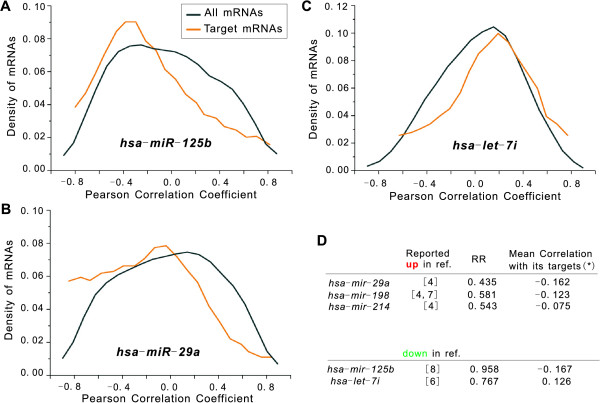
Relationship between the transcript levels of individual miRNAs and their targets in prostate cancer. Global density distribution of the Pearson correlation coefficients between the expression of mRNAs and the expression of miR-125b (A), miR-29a (B) and let-7i (C). The black-lined curves show the distribution of the correlation coefficients for all mRNAs and the orange-lined curves show the correlation coefficient distribution for only PicTar target mRNAs of miR-125b, miR-29a and let-7i. (D) A list of differential expressed miRNAs (ref: reference) that not only show distinct mean correlation coefficients between with their targets and with all mRNAs (asterisk denotes P < 0.05) but also have concordant RR values.